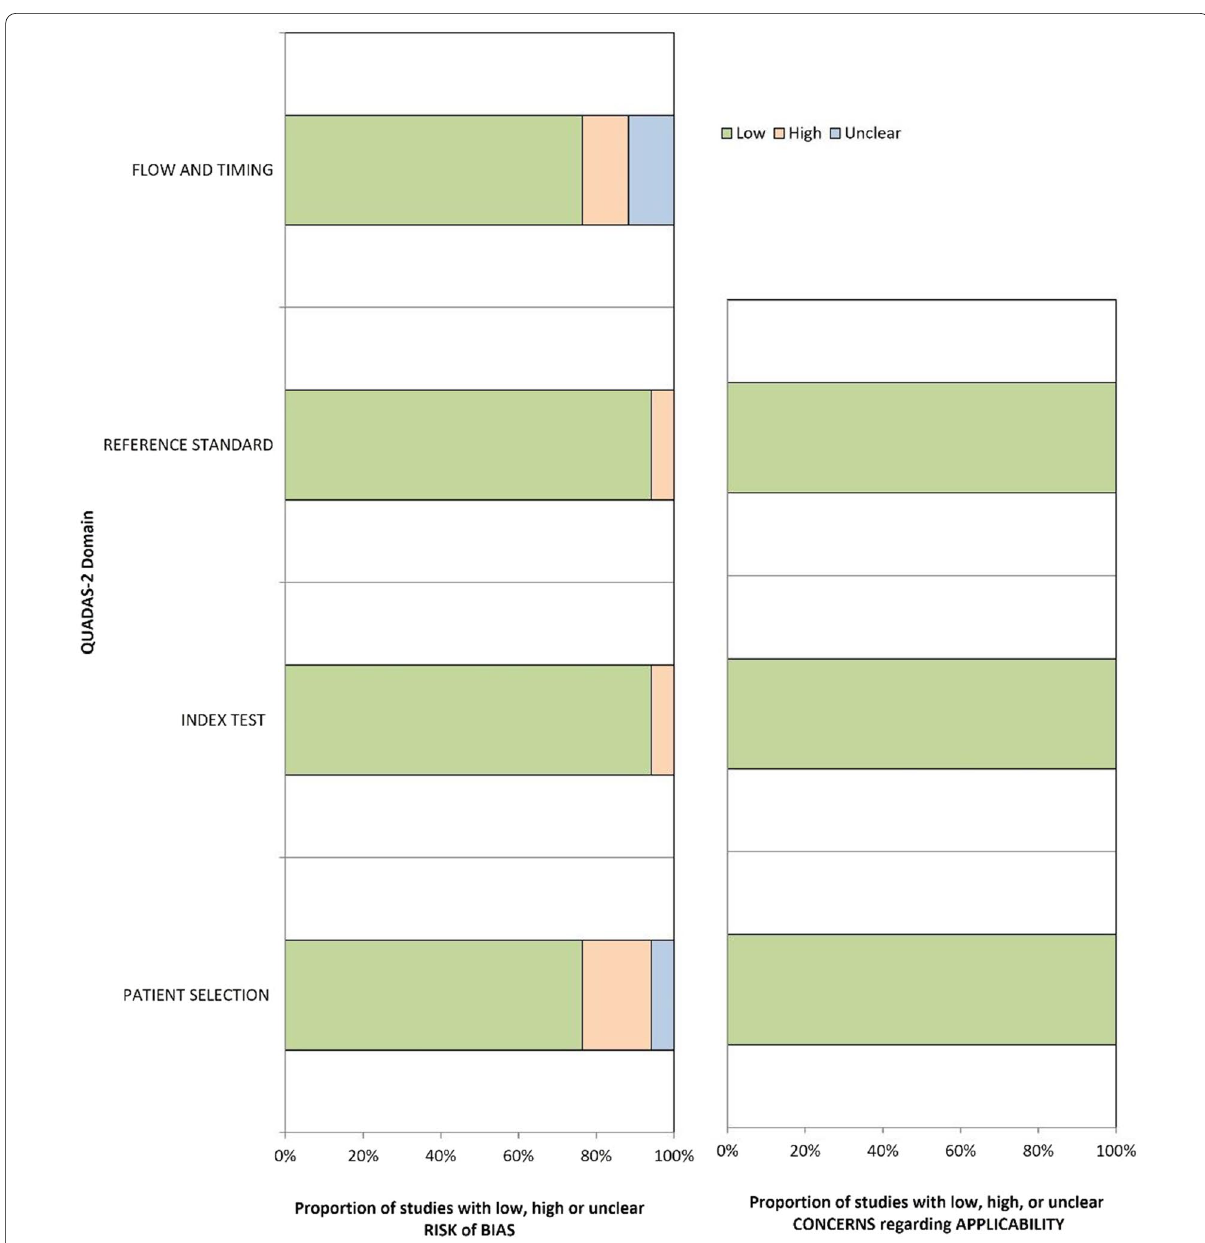
Fig. 2 Summary QUADAS-2 risk of bias and applicability concerns